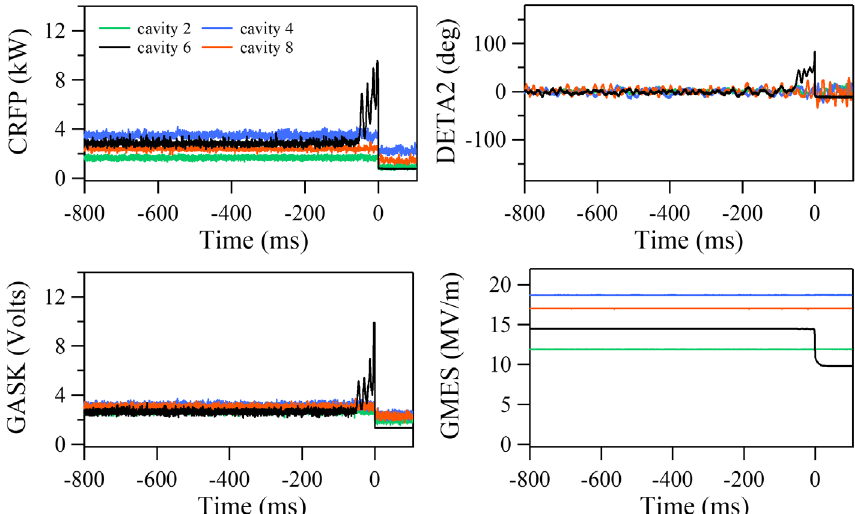
FIG. 15. Waveforms for a 100 ms quench. The plots display the forward power (top left), detune phase angle (top right), a digital signal proportional to the drive voltage (bottom left), and the measured gradient (bottom right). Only four of the eight cavities are plotted for